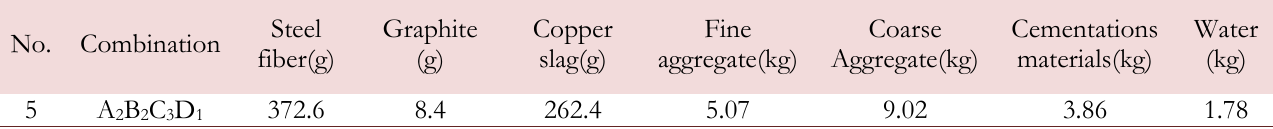
Table 5: Proportion Optimization Table